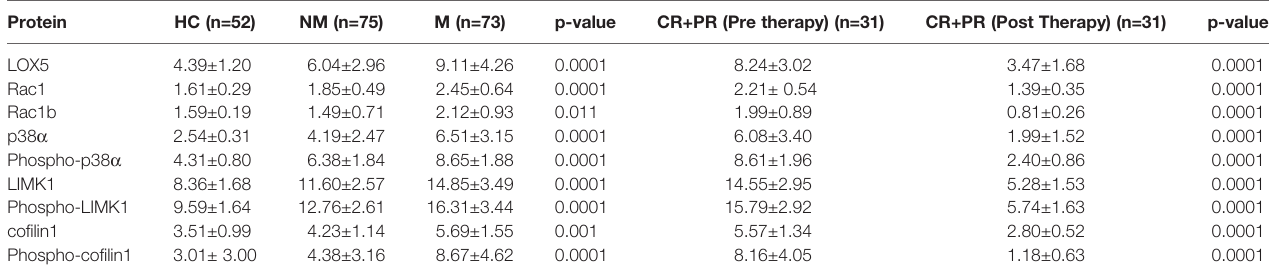
TABLE 2 | Concentration of proteins in Healthy Control (HC), Non-metastatic (NM), Metastatic (M), and CR+PR of M group (pre- and post-therapy). Protein HC (n=52) NM (n=75)